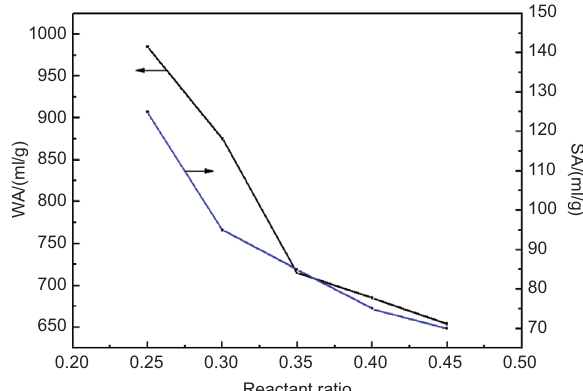
Figure 2 The effect of reactant ratio on the WA and SA of SAR.